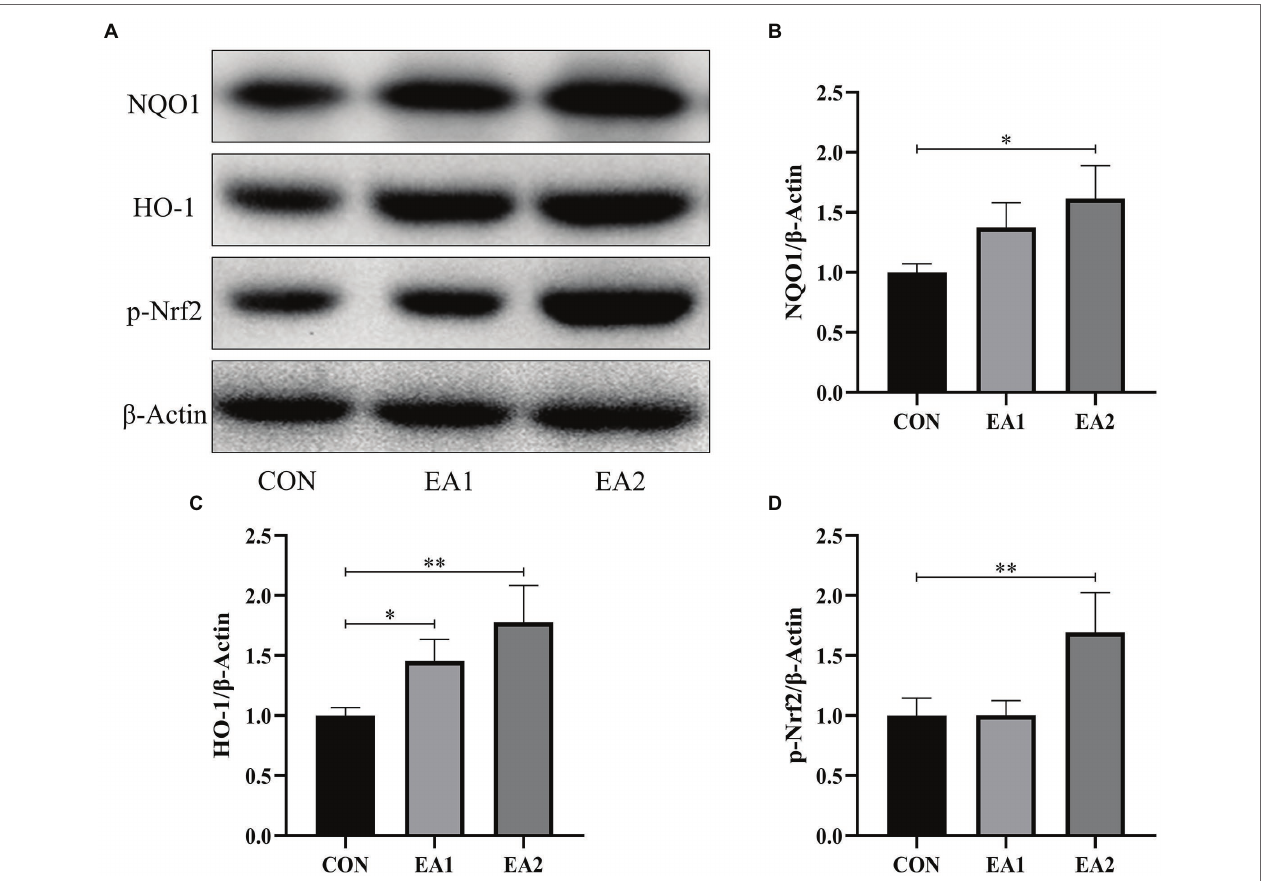
FIGURE 6 | Effects of EA supplementation on Nrf2-ARE signaling-related protein abundances. (A) The liver samples were analyzed by Western blotting using antibodies against NAD(P)H: quinone oxidoreductase 1 (NQO1), heme oxygenase-1 (HO-1), phospho-nuclear factor-E2-related factor 2 (p-Nrf2), and β -Actin (used as the protein loading control). (B) The NQO1/ β -Actin ratio in the liver. (C) The HO-1/ β -Actin ratio in the liver. (D) The p-Nrf2/ β -Actin ratio in the liver. * p < 0.05 and ** p < 0.01 represent significant differences compared with the control